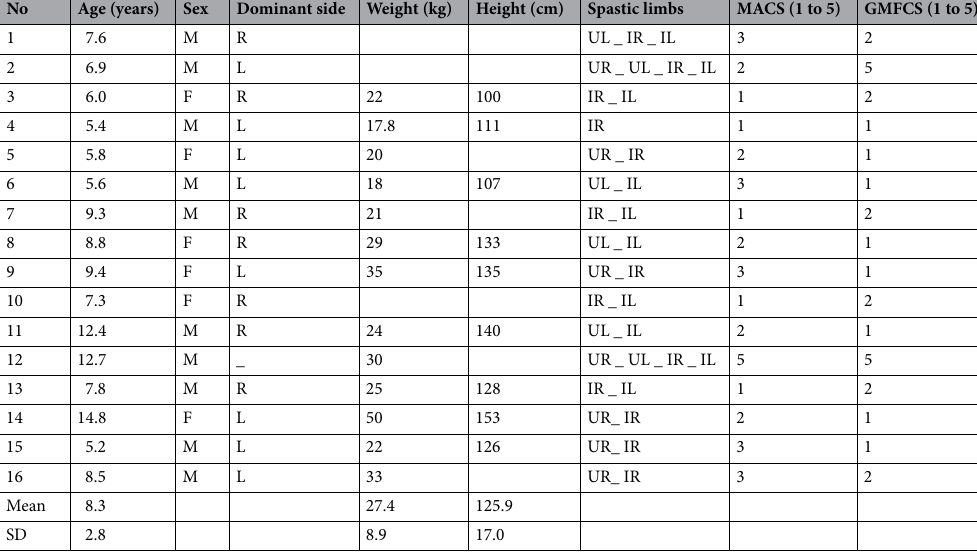
Table 2. Characteristics of group 2 and 3 (cerebral palsy children, U = upper limb, I = lower limb, R = right, L =